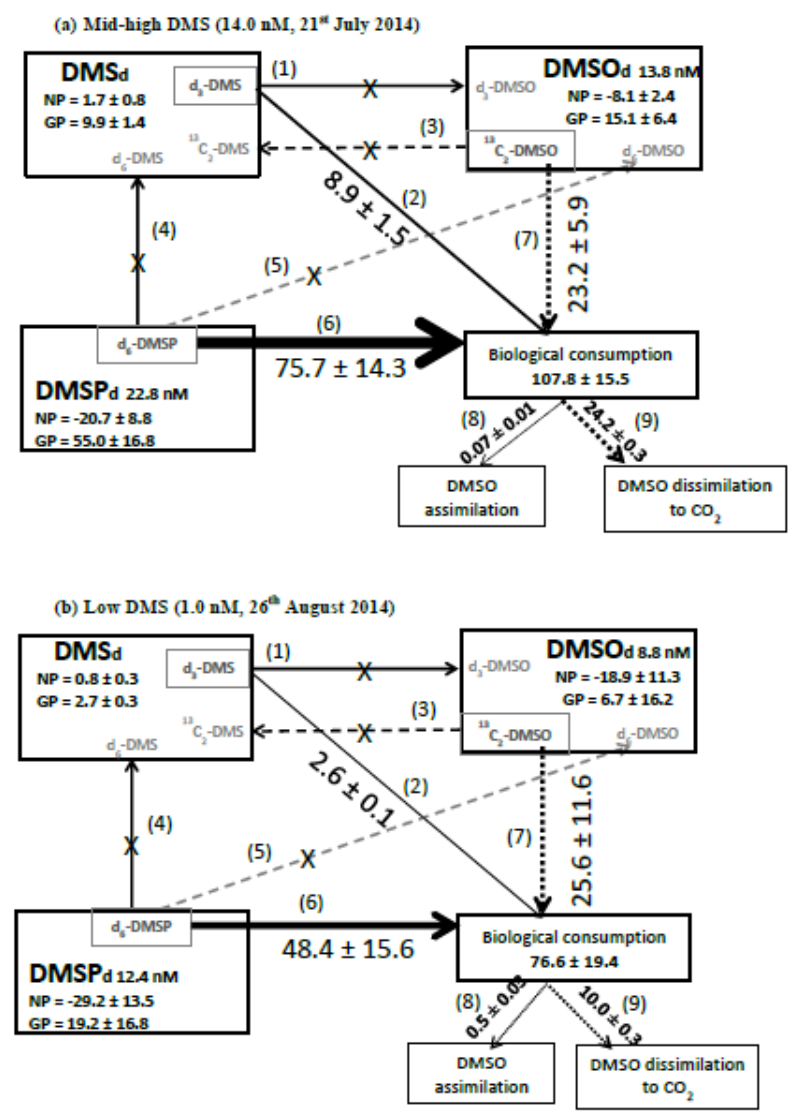
Figure 5. Box model summarising organic sulfur transformation rates (nM d − 1 ) under ( a ) mid-high concentrations of DMS (14.0 nM, sampled on 21 July 2014) and ( b ) low concentrations of DMS (1.0 nM sampled on 26 August 2014). These were the only two dates when all organic sulfur transformation rates were simultaneously determined. NP refers to net production and GP to gross production. Added stable tracers (in grey boxes) and their transformation products are indicated in grey text. Transformations labelled 1–9 are all microbial processes: (1) oxidation of DMS to DMSO d (appearance of d 3 -DMSO), (2) consumption of DMS (corrected loss of d 3 -DMS), (3) reduction of DMSO d to DMS (appearance of 13 C 2 DMS), (4) enzymatic cleavage of DMSP d to DMS (appearance of d 6 -DMS), (5) conversion of DMSP d to DMSO d (appearance of d 6 -DMSO), (6) consumption of DMSP d (corrected loss of d 6 -DMSP), (7) consumption of DMSO d (corrected loss of 13 C 2 -DMSO d ), (8) DMSO d assimilation for growth (incorporation of 14 C-DMSO d into the particulate phase), and (9) DMSO d dissimilation to CO 2 ( 14 CO 2 precipitated as 14 CO 3 ). An “X” denotes no detectable rate was determined during the incubation experiment. Rates are shown as ± 1 standard deviation based on three replicates.